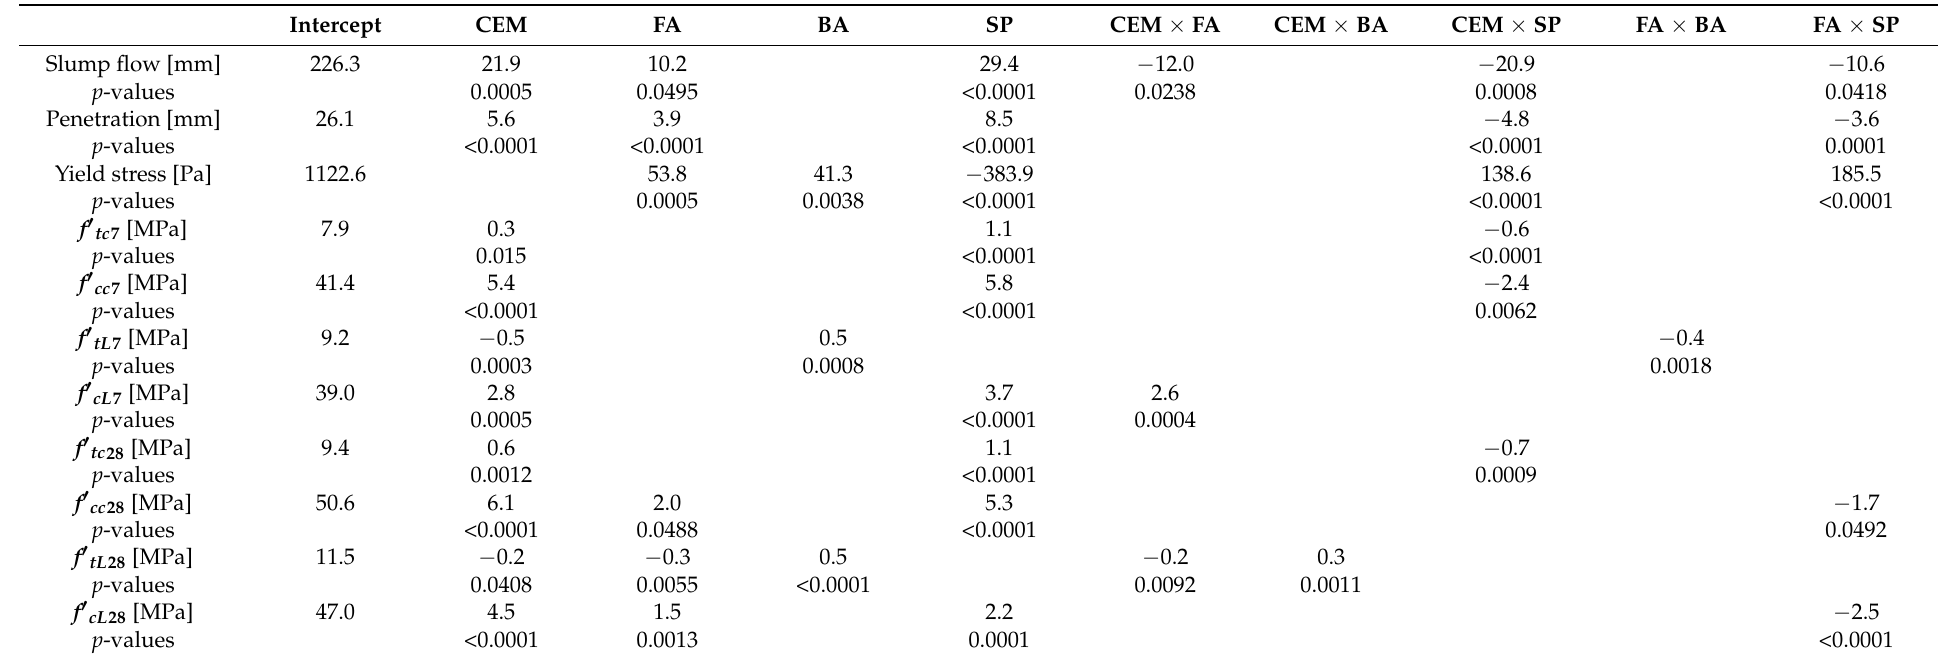
Table 9. Regression coefficients and p -values for all measured